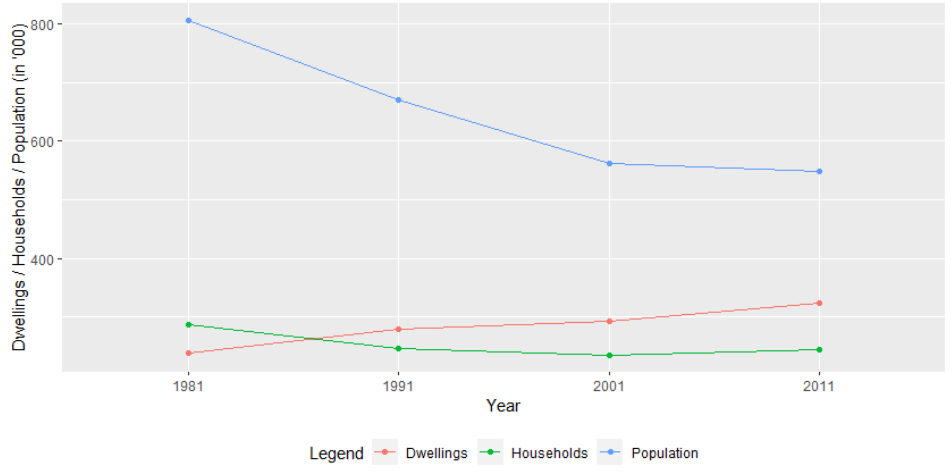
Figure 3. The evolution of family dwellings, household and population in Lisbon, 1981–2011. Source: Own elaboration, with data from Census records 1981–2011.